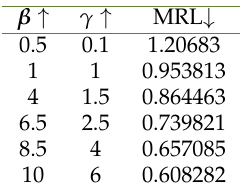
Table 2. The MRL of the MOPA distribution for specific model parameters with ( θ = 0.5, =